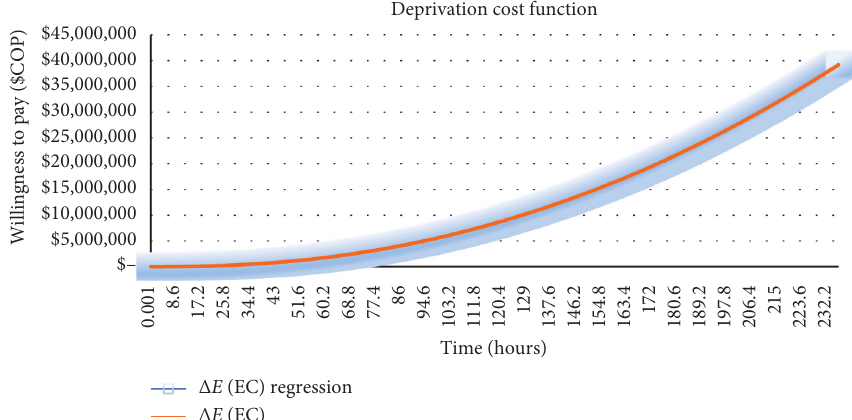
Figure 3: Comparison of the behavior between the nonlinear deprivation function Δ E (EC) and the linear regressions of the proposed piecewise function.